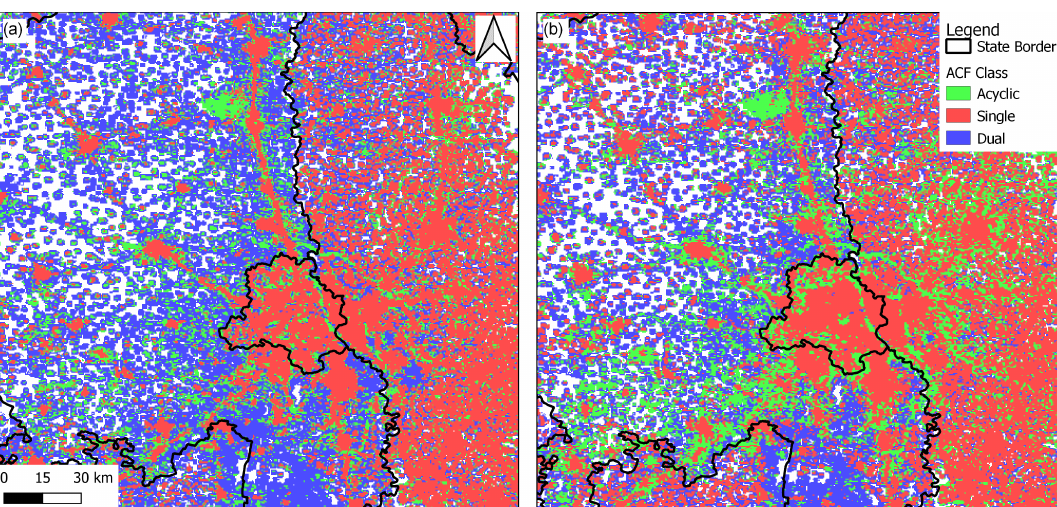
Figure 15. ACF classification results’ comparison near Delhi on the map. Lit area mask applied. ( a ) Rule based classification. ( b ) Supervised